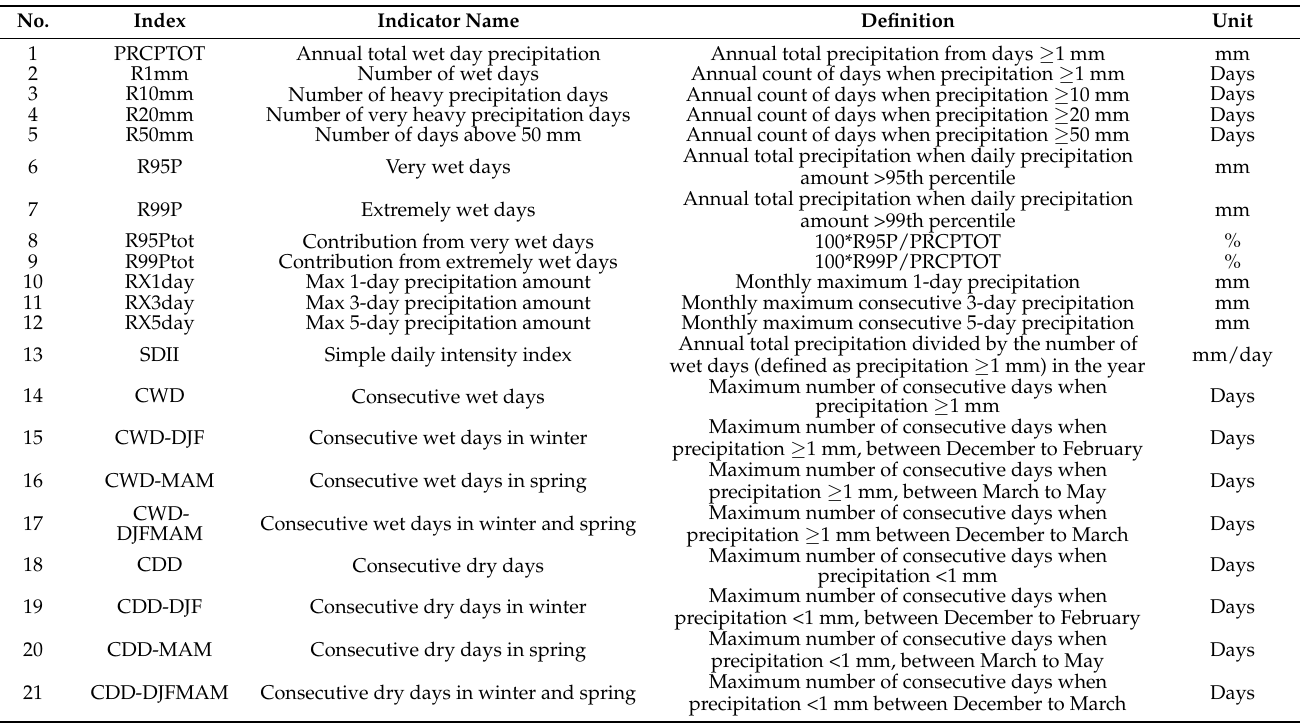
Table 1. Description of extreme precipitation indices used in this